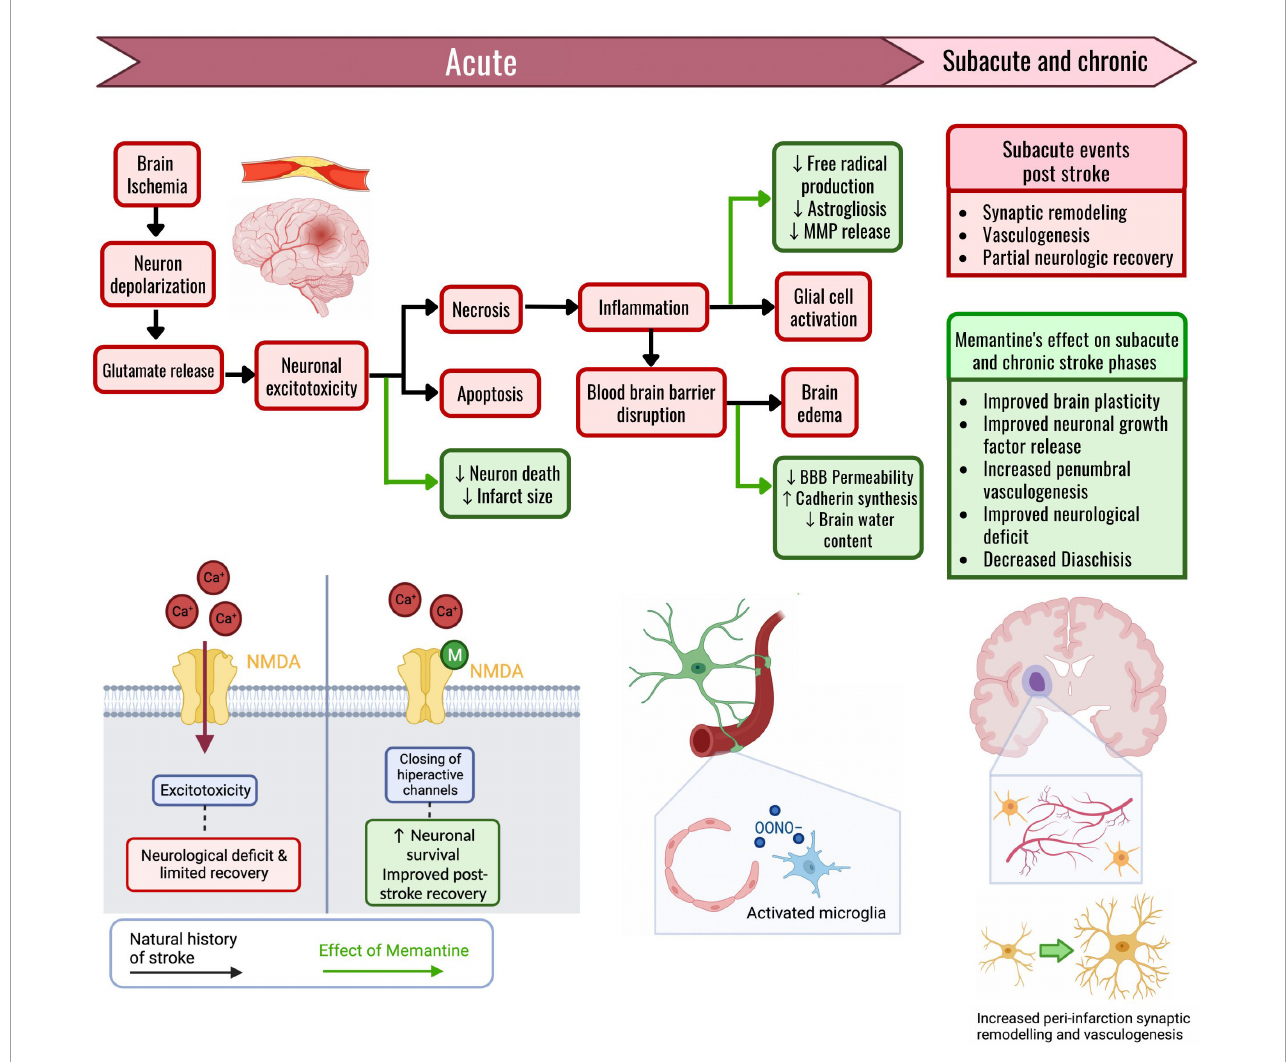
FIGURE1 The effects of memantine on the pathophysiologic cascade of an ischemic stroke. The effects of memantine administration are marked through green arrows. When a region of the brain suffers ischemia, the neurons initially depolarize. The wave of depolarizations triggers glutamate release, and neuronal permeability to calcium increases due to the NMDA channel opening. Prolonged ischemia with increased intracellular calcium thus causes excitotoxicity, with cellular death through necrosis and apoptosis. The main effect of memantine is through the blockade of the hyperactive NMDA channels that drive excitotoxicity. Memantine given in these acute stages of ischemic stroke results in an inhibition of neuron death and causes a reduction in stroke size. Tissue necrosis triggers inflammation, disrupts the blood–brain barrier (BBB) through endothelial damage, and activates both microglia and astrocytes, causing brain edema. Memantine can reduce the activation of reactive cells, thus reducing peroxynitrite formation and MMP release, consequently helping maintain the impermeability of the BBB. The preservation of BBB permeability results in an attenuated brain edema formation. Following a stroke, in the subacute and chronic stages, there is a partial functional recovery mainly due to synaptic remodeling and peri-infarct vasculogenesis. If memantine is given during these latter stages, there is an increase in the concentration of neuronal growth factors, along with an improved capacity for synaptic remodeling. Memantine induces an increase in axonal sprouting, and an increase in peri-infarct vasculogenesis, thus giving further support to the recovering neurons around the ischemic core. Through these mechanisms, memantine improves the functional recovery that follows an ischemic